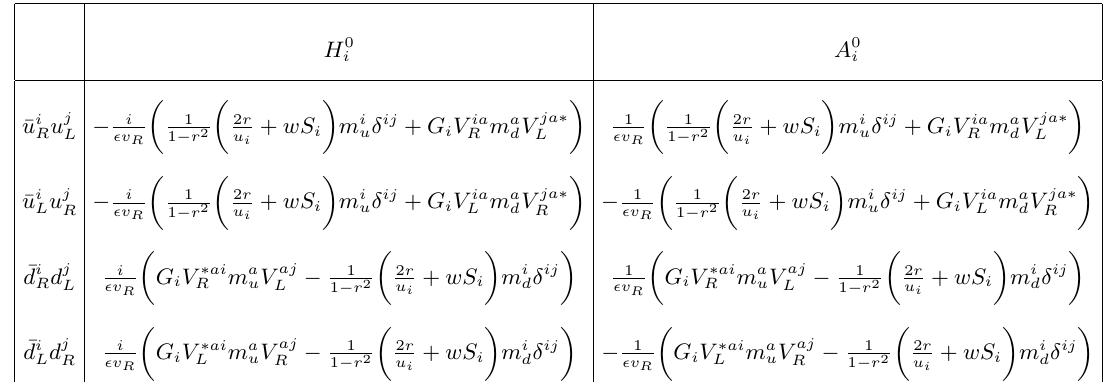
Table 7 . Couplings of neutral scalar bosons to quarks (the adaptation to leptons is straightforward). H 0 does not couple to fermions at this order. 3